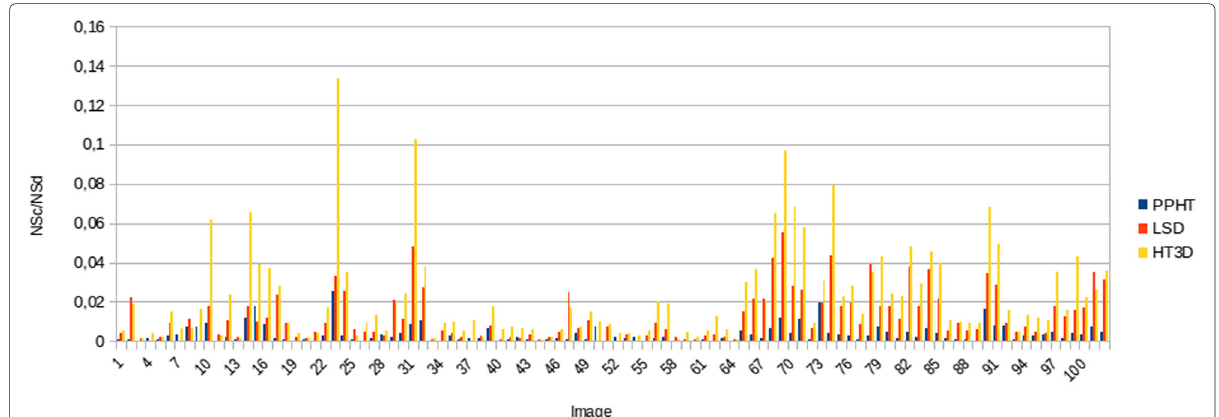
Fig. 24 Ratio between NS c (number of detected segments matching the ground truth data) and NS d (total number of detected segments) for the whole dataset considering d S = 2 (distance between ground truth and detected line segments). The differences among the three methods when reducing d S become more significant, showing the greater accuracy of HT3D compared with the other two